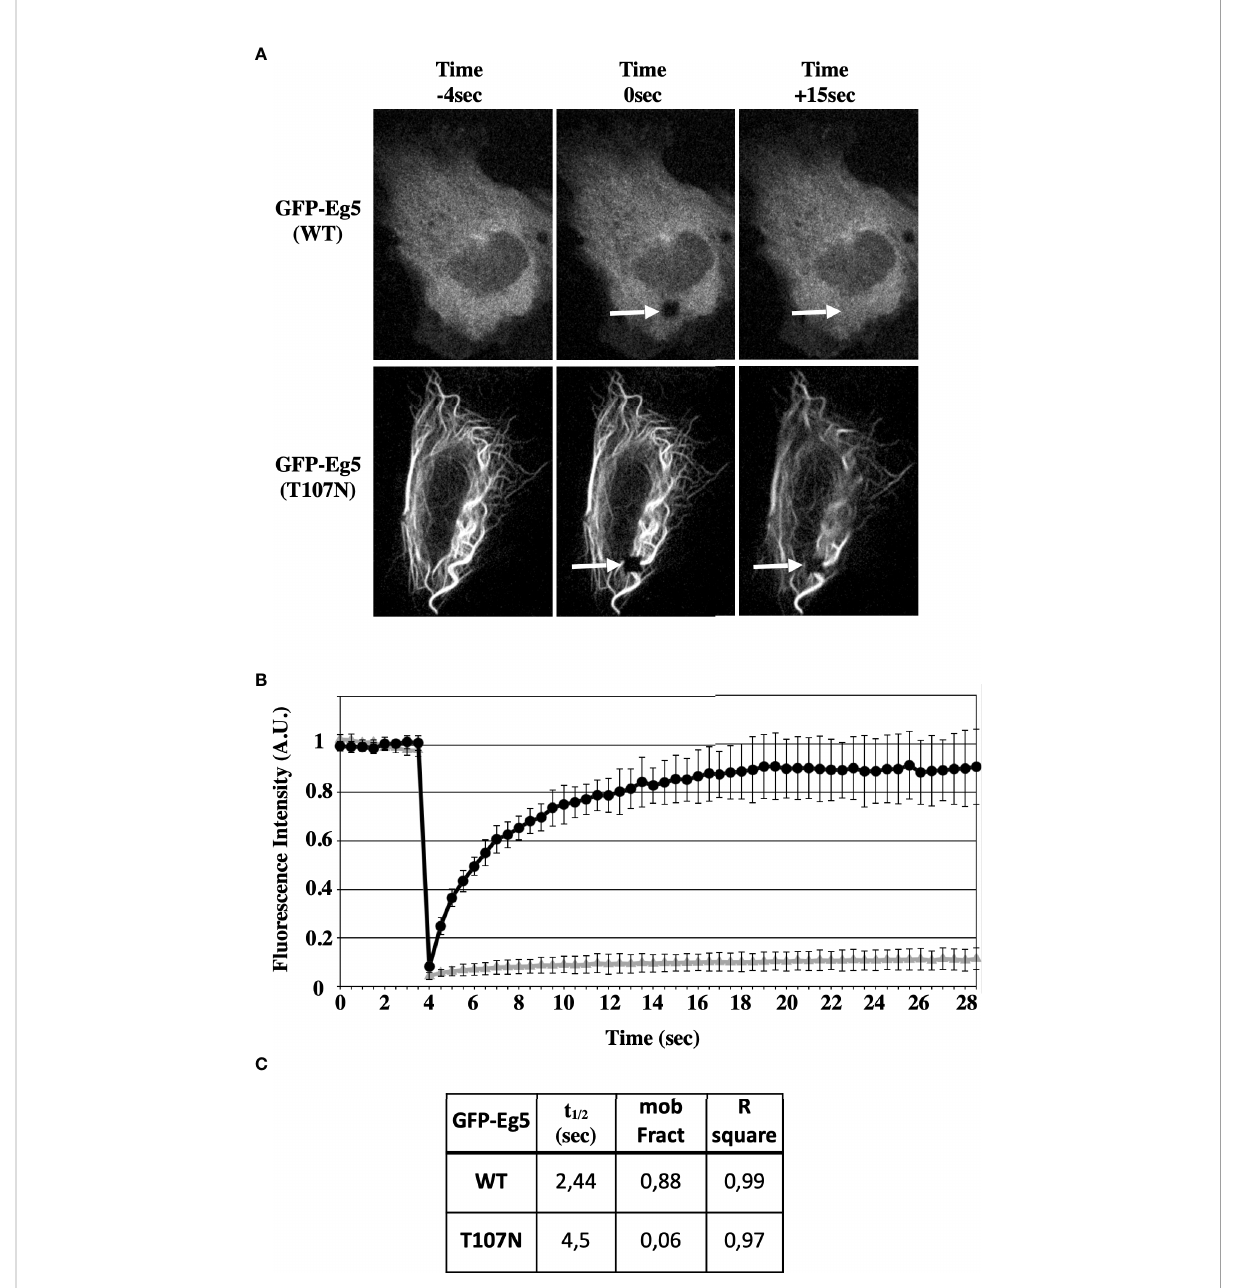
FIGURE 7 STLC resistant Eg5(T107N) variant binds microtubules in a non-reversible manner in the absence of STLC. (A) GFP-tagged Eg5(WT) and -Eg5 (T107N) were transfected for expression in U-2OS cells. Time lapse video microscopy images 48h following transfection before (-4 sec), immediately after FRAP (0 sec) and after FRAP (15 sec) are shown. Arrows indicate the site of the photobleaching. (B) Recovery of the fl uorescence intensity after FRAP. (C) The measured mobile fraction and the half time represent the ability of GFP-Eg5 to actually replace the photobleached in cytoplasm of living cell during